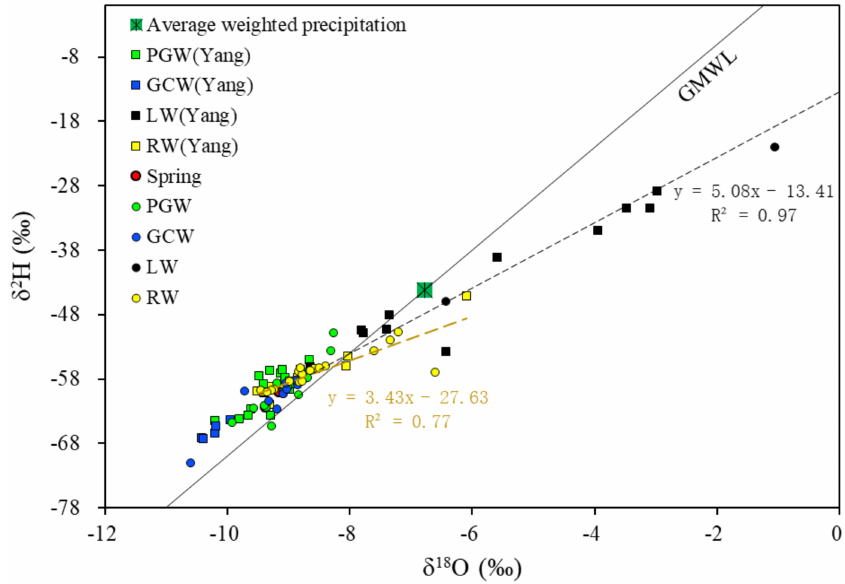
Figure 7. Plot illustrating δ 18 O vs. δ 2 H diagram of groundwater, lake water, river water, and spring water in the study area of the Qaidam Basin, China. Squares represent samples from the literature